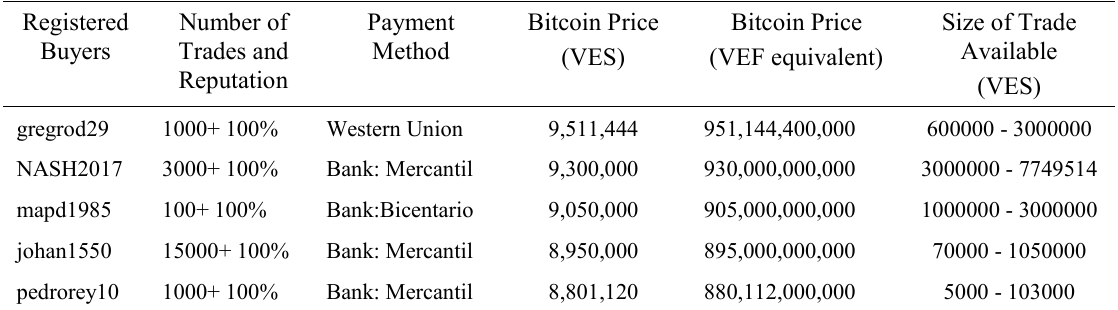
Table 3. Bitcoins for Purchase by Registered Buyers, Payment and Transaction